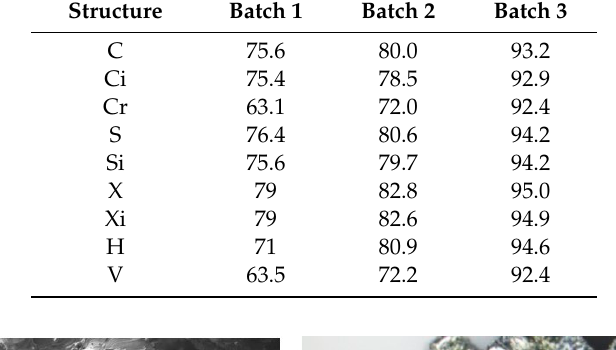
Table 1. Nominal percent porosity (as per Computer-Aided Design—CAD) of the structures investigated.